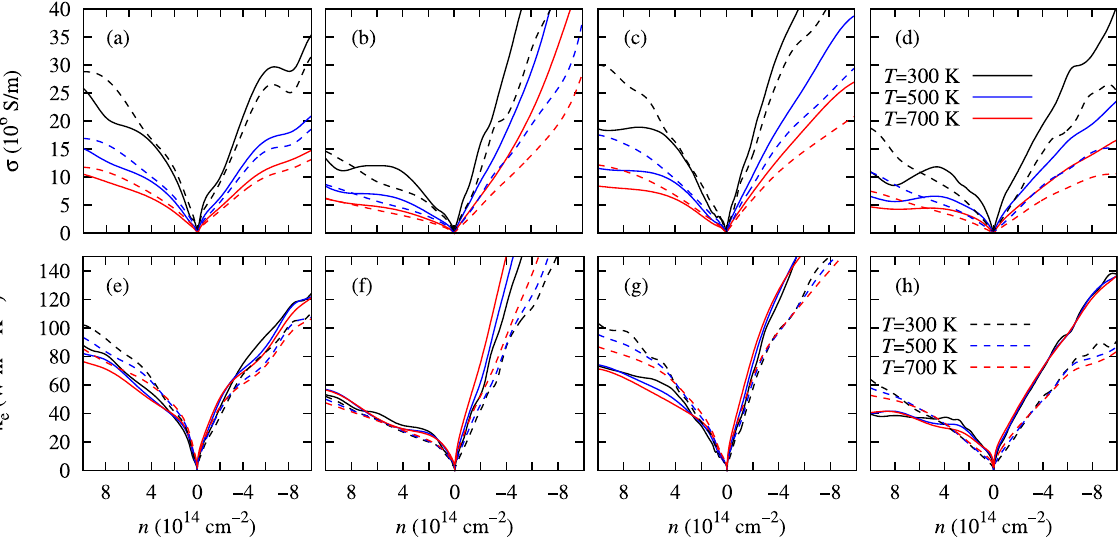
Figure 3. Electrical ( σ ) and electronic thermal ( κ e ) conductivities for the ( a , e ) SnSe, ( b , f ) SnS, ( c , g ) GeSe, and ( d , h ) GeS along the armchair (solid lines) and zigzag (dashed lines) directions at 300 K, 500 K, and 700